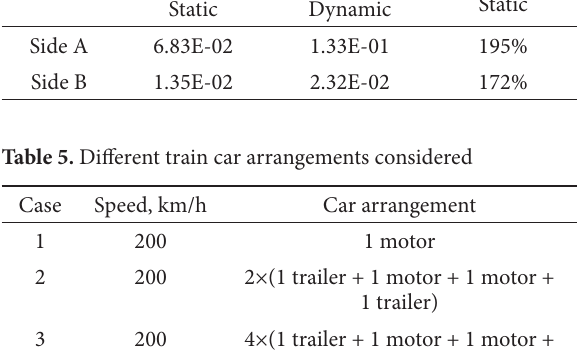
Fig. 10. Discrete stress variation counts at point C under different line load Table 4. Cumulative damage at point C under different line load Line load